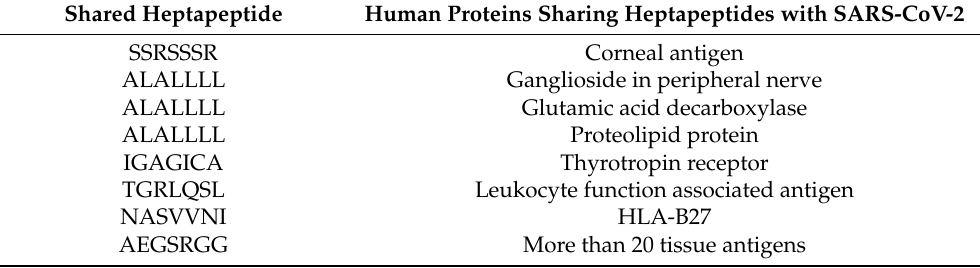
Table 2. Short list (8/34) and description of human proteomes and the peptide sequences they share with SARS-CoV-2